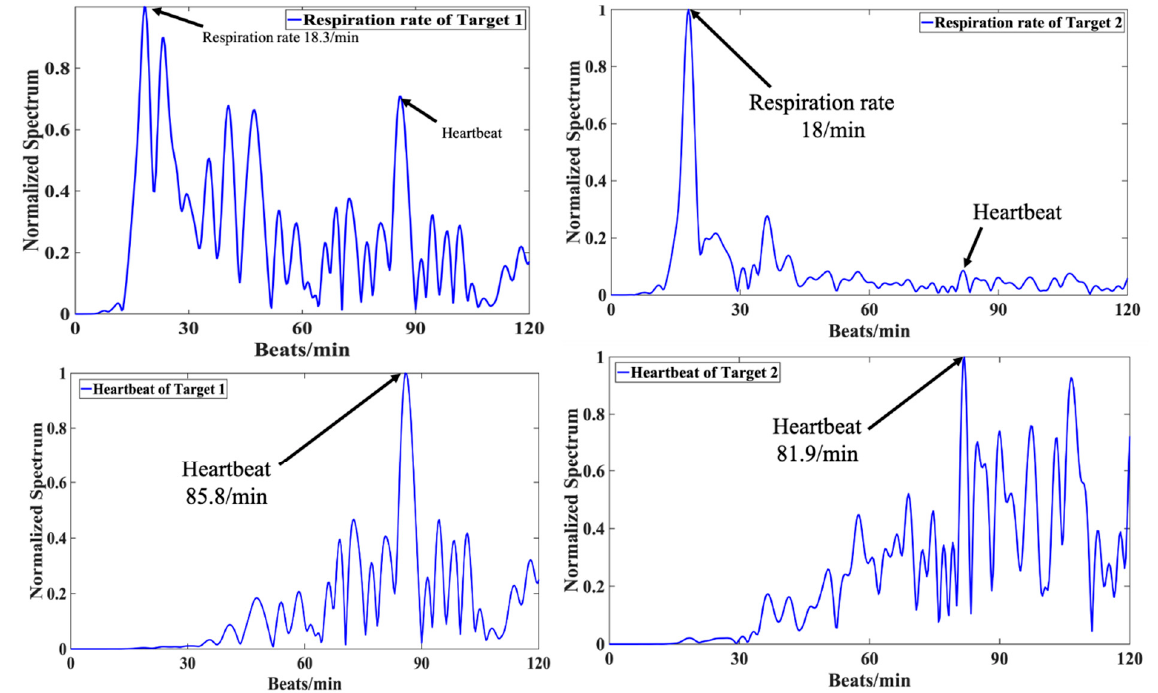
Figure 18. Measured respiration and heartbeat rates of Target 1 and 2 using MTM LWA based on SIL radar sensor module [51].